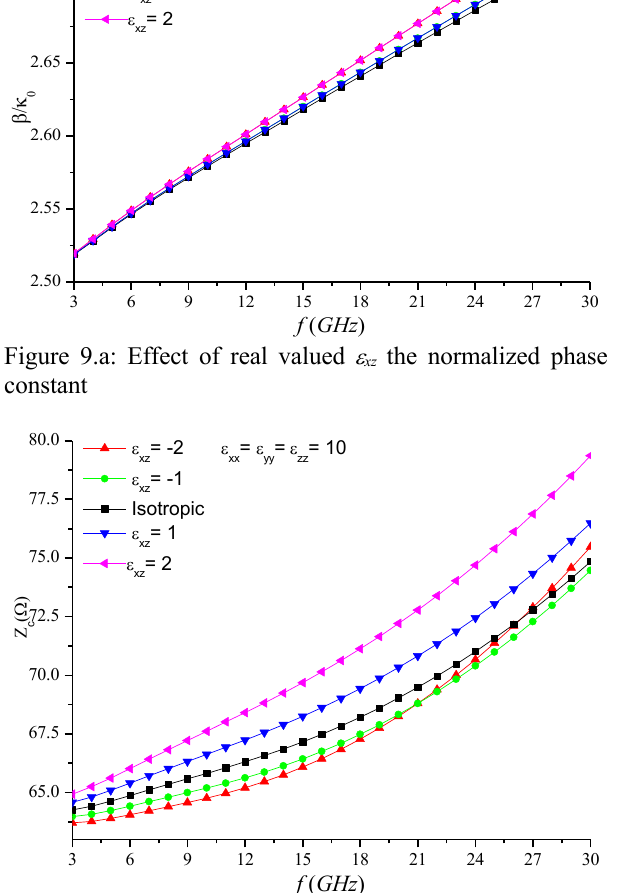
on the characteristic xz